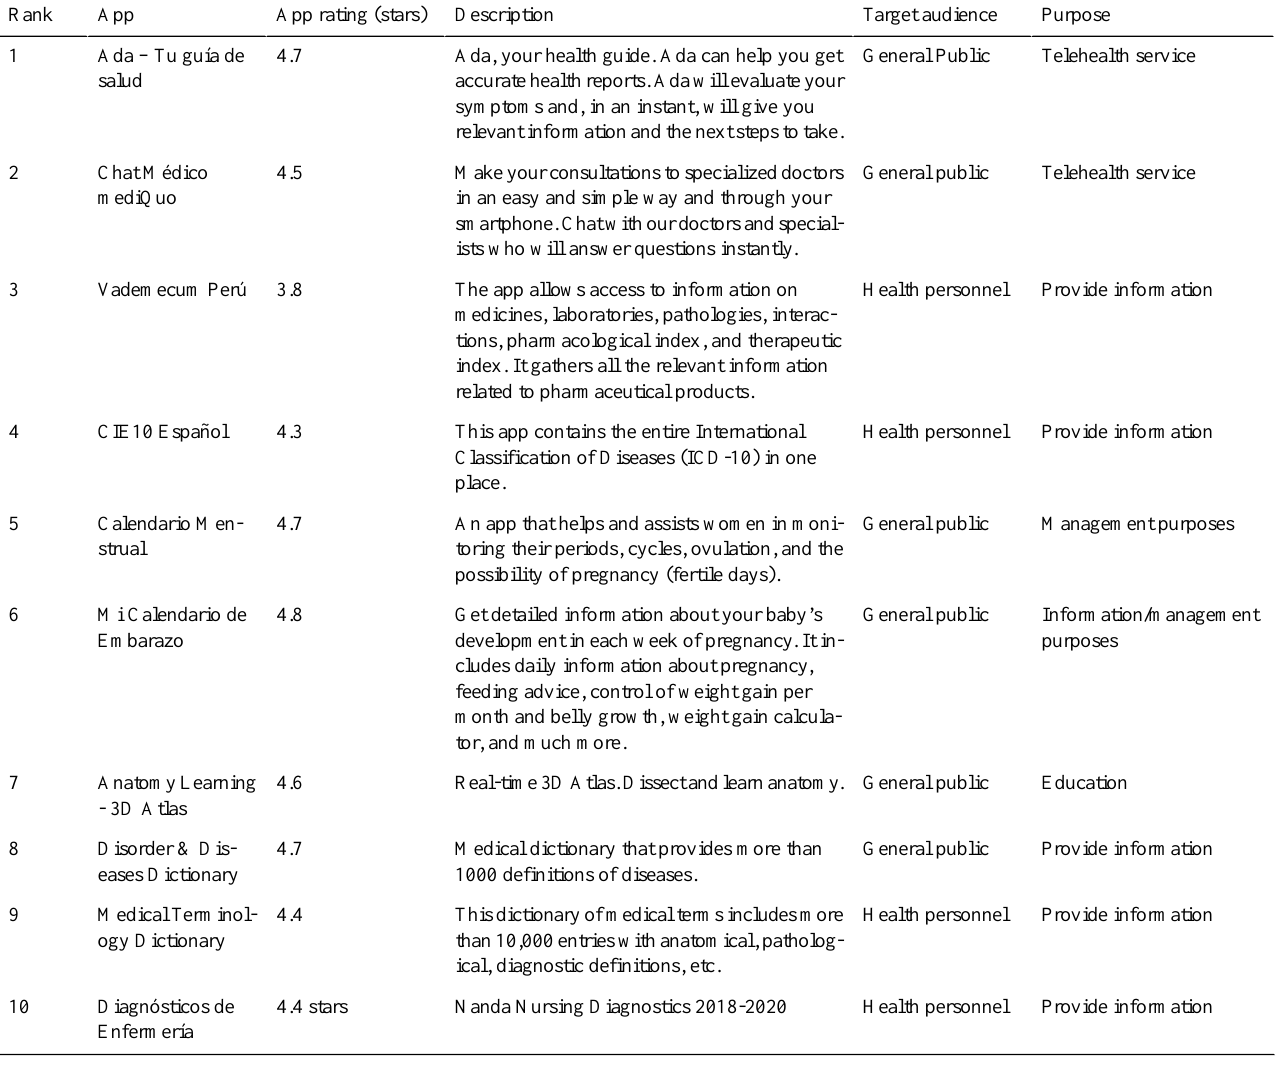
Table 2. Top 10 most downloaded medical apps in the Peruvian territory as of May